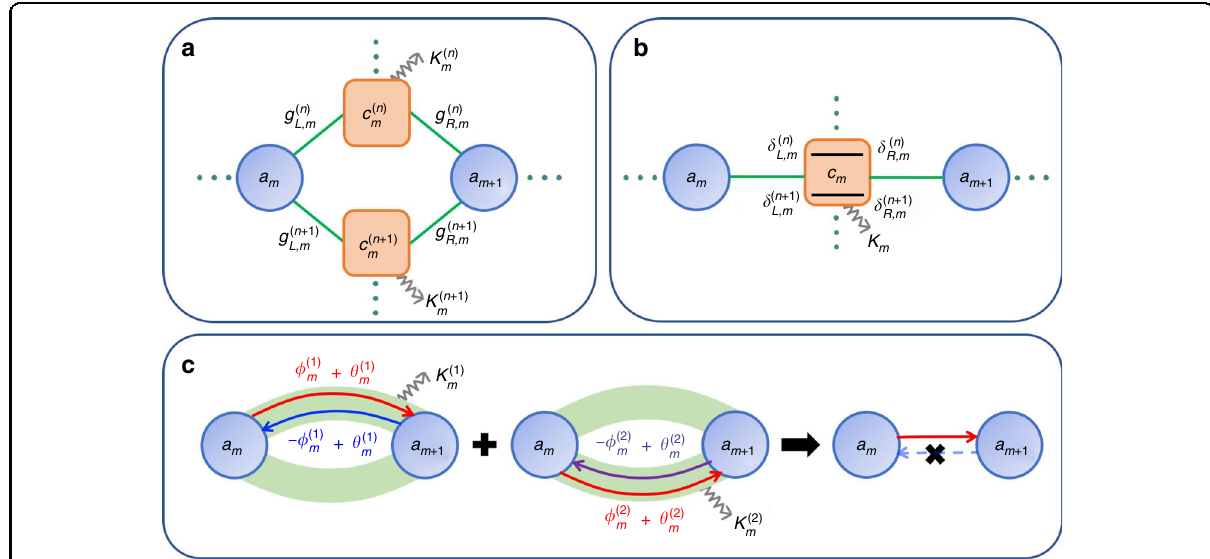
Fig. 1 Schematic description of the scheme. a Sketch of a system with an array of main resonance modes a m connected via a series of connecting modes c ð n Þ m . The loss of c ð n Þ m is represented by the decay rate κ ð n Þ m . The coupling coef fi cient between a m ( a m + 1 ) and c ð n Þ m is denoted by g ð n Þ b Sketch of a multichannel coupled system with synthetic frequency dimensions. Only one connecting mode c m is used to connect a m and a m + 1 , whereas the coupling between a m ( a m + 1 ) and c m has a series of detunings δ ð n Þ nonreciprocity. For the fi rst (second) coupling channel, the coherent coupling phase is ϕ ð 1 Þ backward coupling, whereas the loss phases are θ ð 1 Þ (destructive) interference can be achieved for the forward (backward) coupling. Thus, the forward coupling survives while the backward coupling